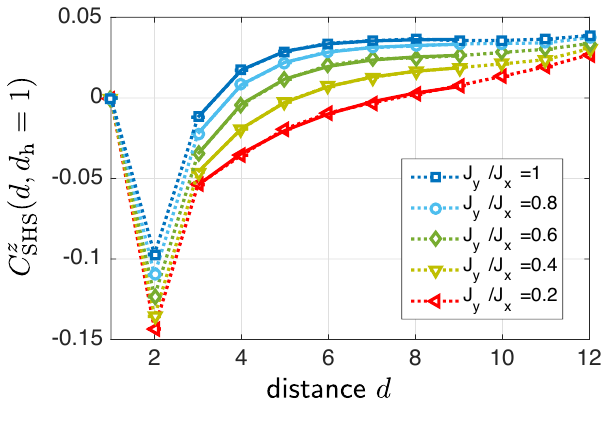
( d , d = 1 ) h SHS as shown in Fig. 10. st . The solid lines indicate fits x ) . y